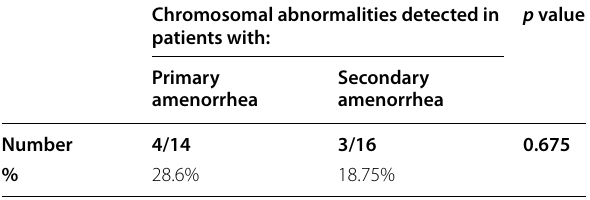
p : p value for comparing between primary and secondary